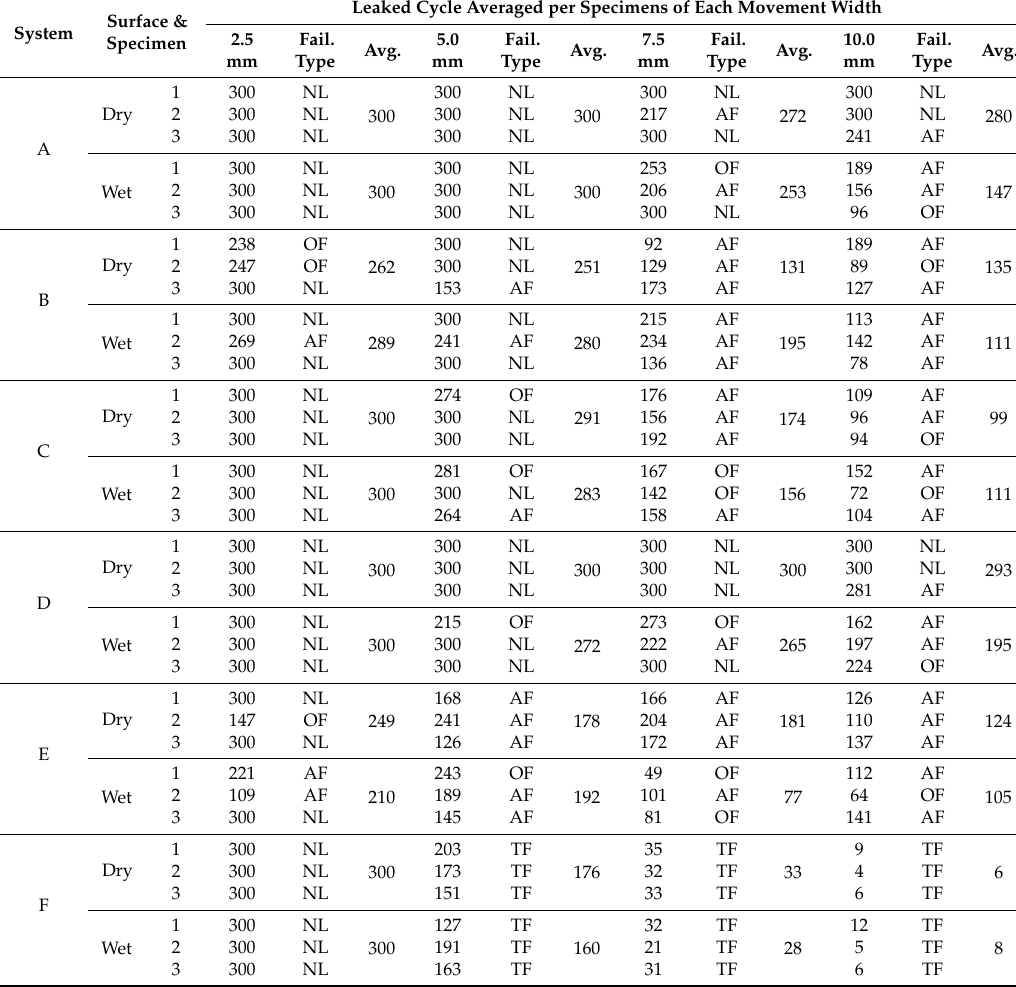
Table 12. Results of the leaked cycles per each waterproofing system